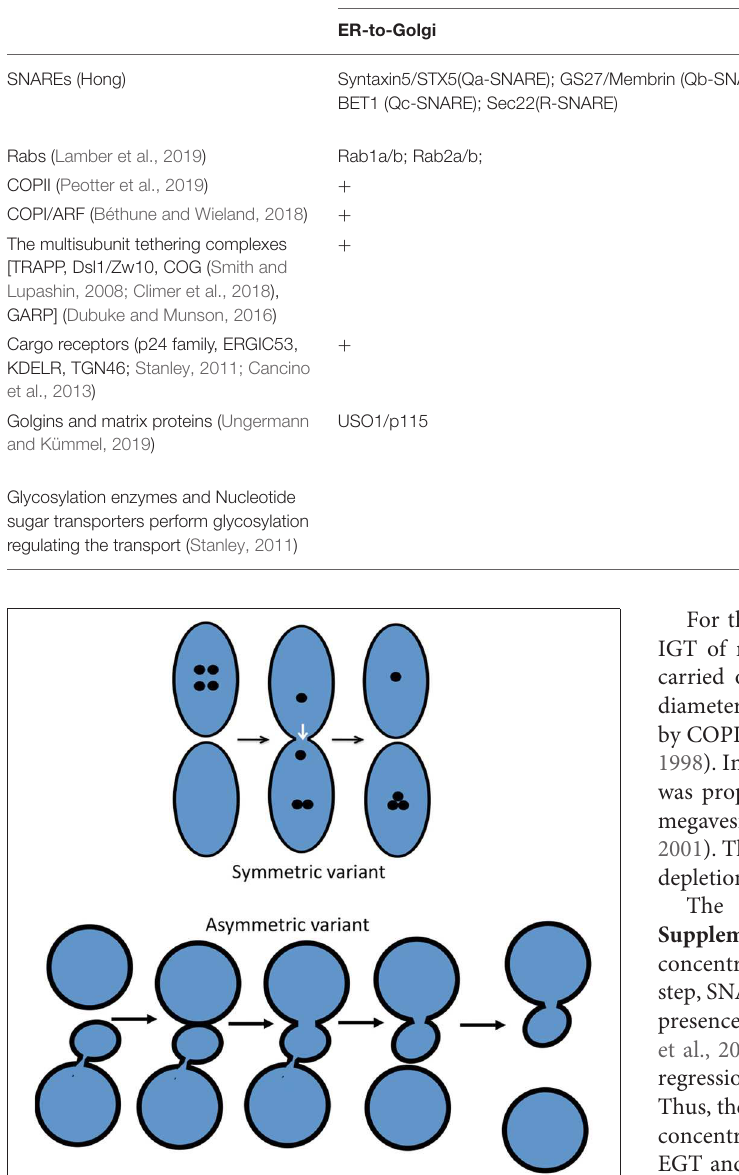
TABLE 1 | Main molecular machines involved in the ER-to-Golgi and intra-Golgi transport steps (summarized from current reviews). Machine